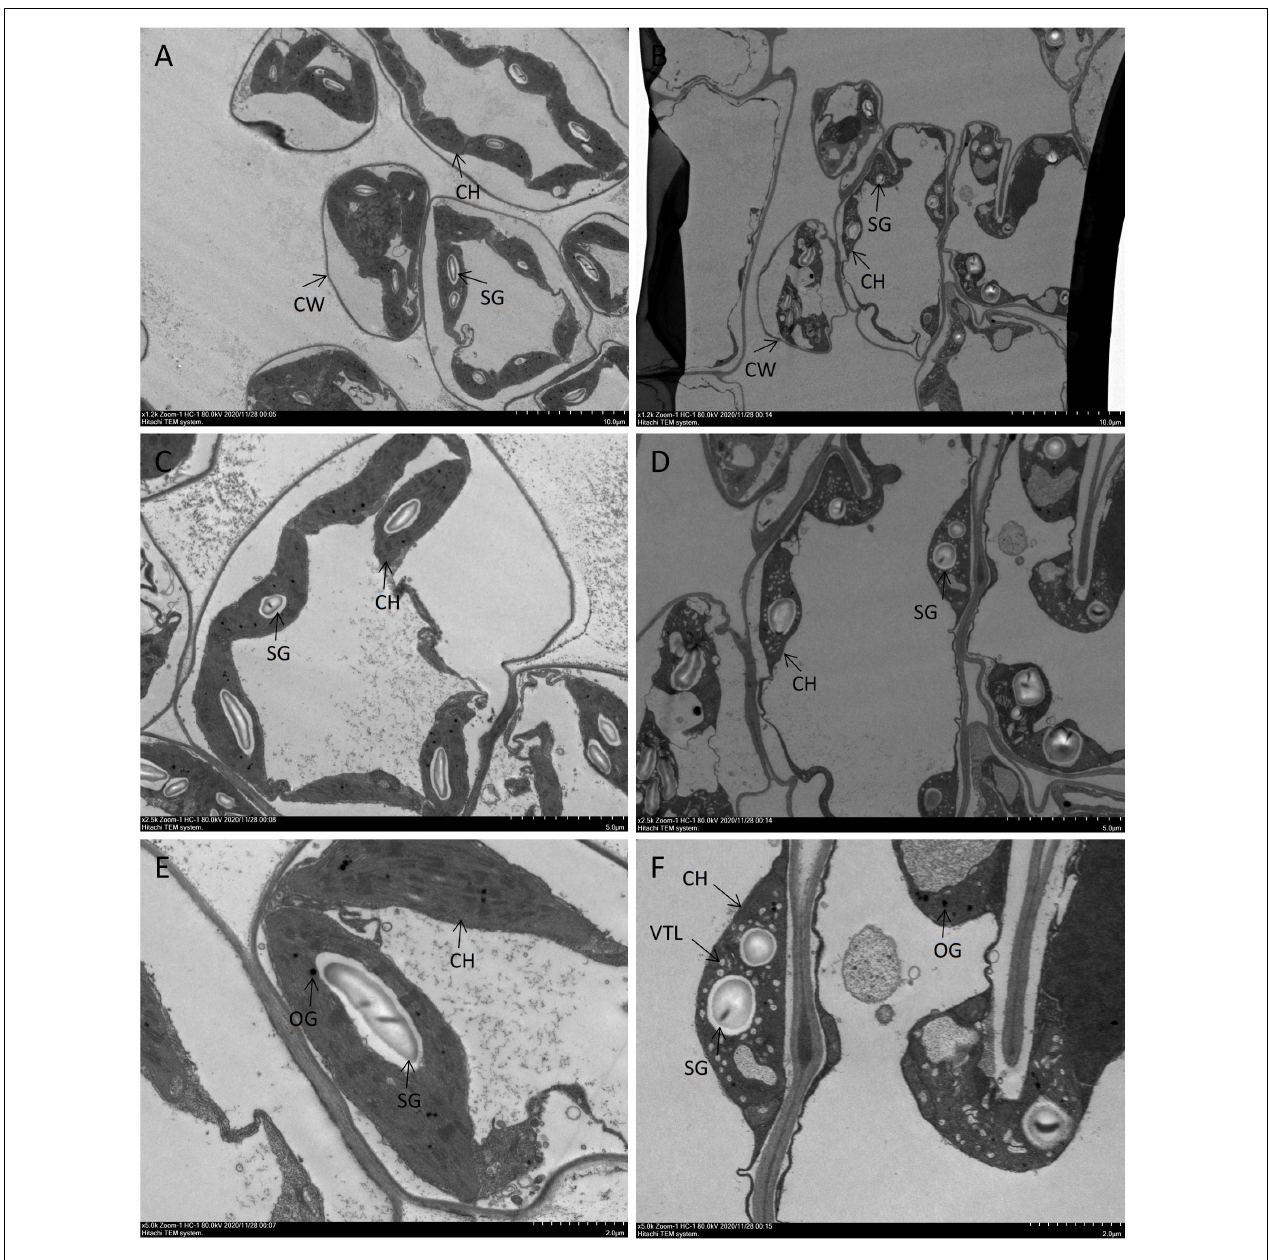
FIGURE 3 | Comparison of the ultrastructure of MCB leaves under the red and blue lights. (A,C,E) Represented the blue-light treatment; (B,D,F) Represented the red-light treatment. SG, starchgrains; OG, osmiophilicgranules; CH, chloroplast; CW, cellwall; VTL, vesiculation of thylakoid